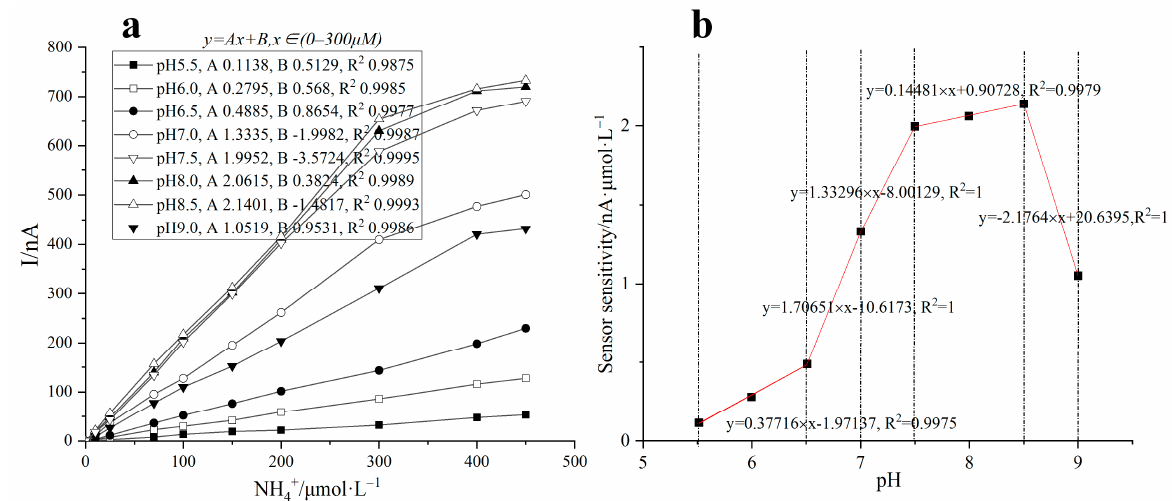
Figure 8. Dynamic response range of biosensor toward different concentrations of ammonium ion under different pH ( a ); Look-up table method based on piecewise linear interpolation for pH compensation ( b ). The concentrations of GLDH, α -Ketoglutarate and NADH on the enzyme electrode were 2.0 U, 28 mM and 1.3 mM, respectively. The experimental temperature was controlled at 37 °C.